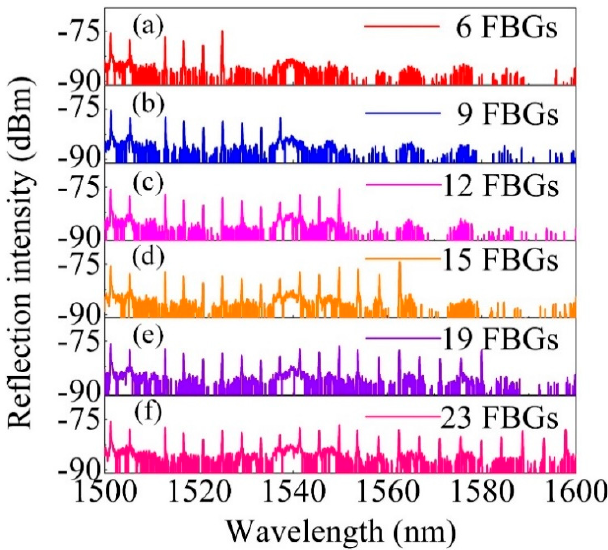
Figure 3. ( a – f ) Reflection spectrum evolution of an FBG array inscribed in a H 2 -free